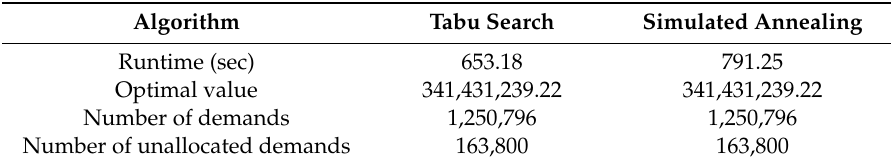
Table 21. Runtime and the optimal value of the function by Tabu Search and Simulated Annealing algorithm for existing stations.